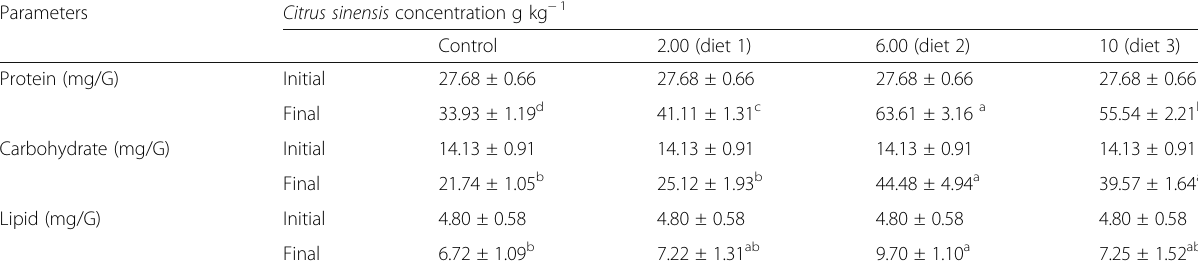
Table 3 Muscle biochemical composition of Catla catla fed with different concentrations of Citrus sinensis -supplemented diets during the experimental